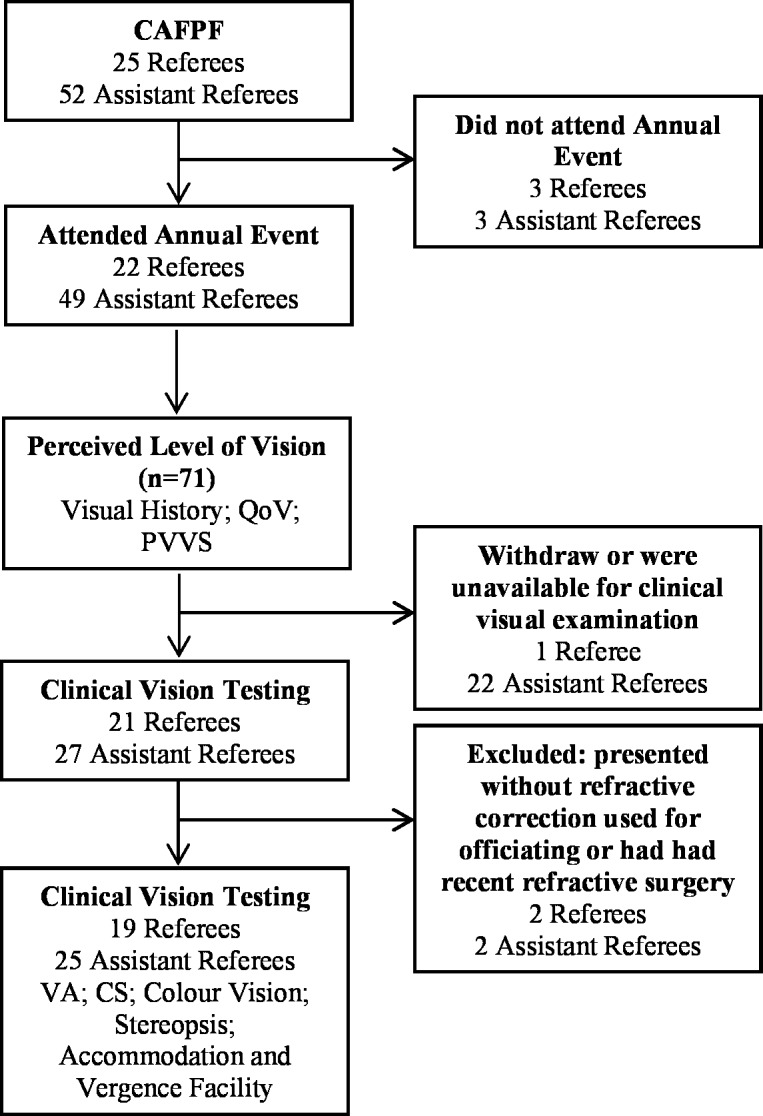
Flow chart summarizing participant recruitment.CAFPF: Conselho de Arbitragem da Federação Portuguesa de Futebol (Portuguese Referee's Committee); QoV: quality of vision questionnaire [12]; PVVS: rating-scale to measure the preference values that officials assign to their global vision status [13]; VA: visual acuity; CS: contrast sensitivity.